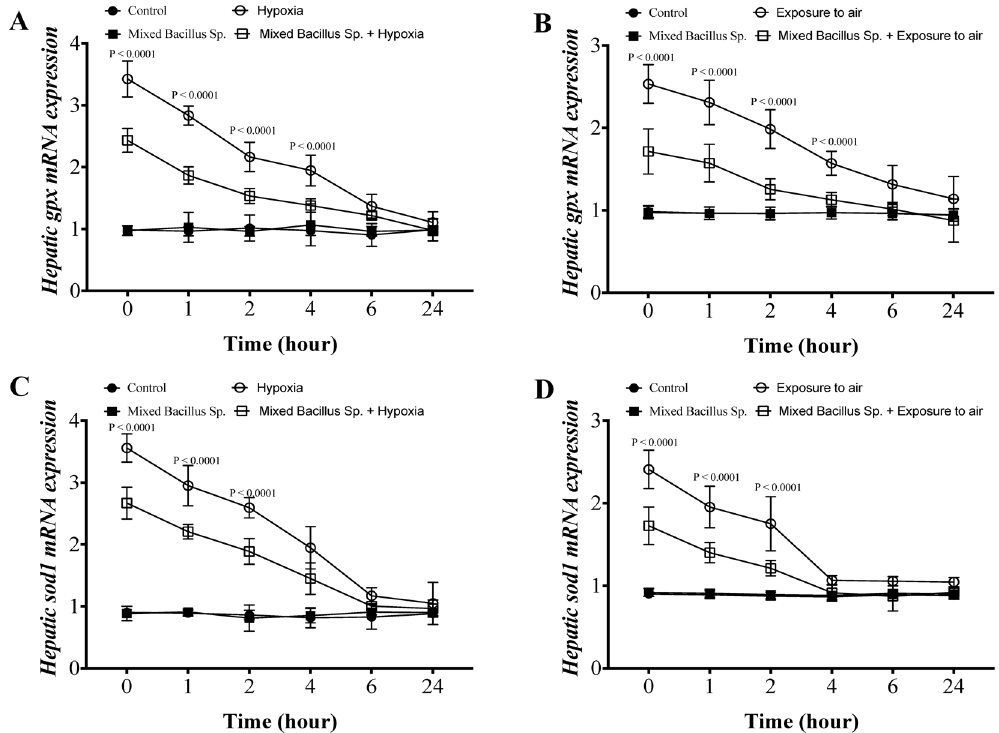
Figure 7. A mixed Bacillus Species reduces the hepatic glutathione peroxidase ( gpx ) and superoxide dismutase ( sod1 ) gene expression. Yellow Perch response to hypoxia and air exposure stress over 24 h as reflected in hepatic mRNA levels of ( A , B ) gpx3 and ( C , D ) sod1 that were quantified using RT-qPCR. Sample size = 9/group. Two- way Repeated measure ANOVA followed by comparing mixed Bacillus spp + stressed group to stressed groups was applied at two-tail significance level (P < 0.05). Data represented in mean ±